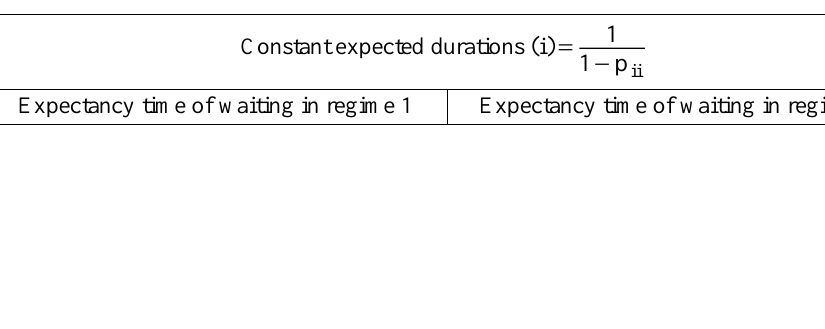
Table 12: Results of expectancy time in a regimen (authors’